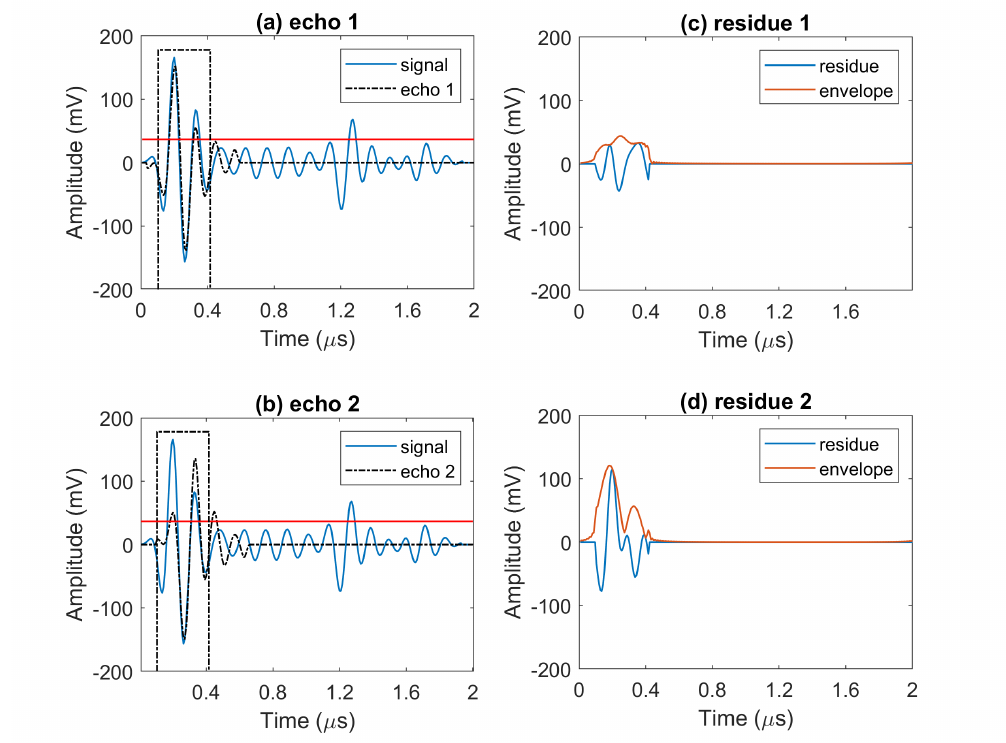
Figure 8. Full wave A-scan with two possible choices of echo models that differ by location, amplitude and phase in ( a , b ), and corresponding residue signals after subtracting echo models from the signal in ( c , d ).